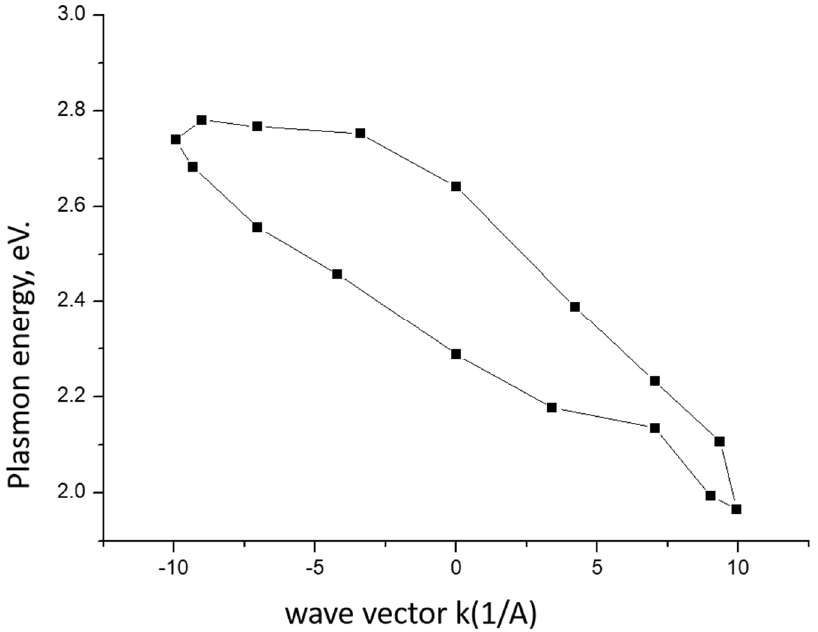
Figure 14. Plasmon dispersion for a thin film of vanadium dioxide № 2 on a sitall with an aluminum sublayer. Table 9. Comparison of the results of studying the dispersion of surface plasmons and calculating the microscopic characteristics for two samples of vanadium dioxide thin films. Vanadium Dioxide Films